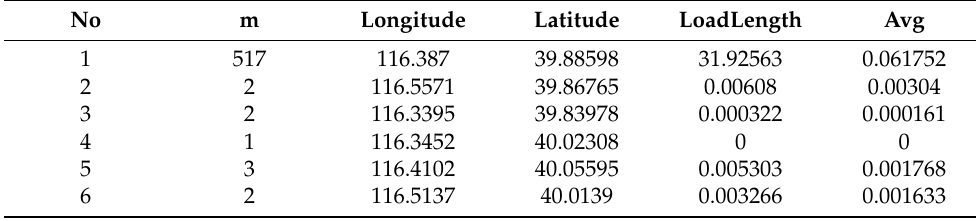
Table 9. The clustering results of HF_DBSCAN for the DS1